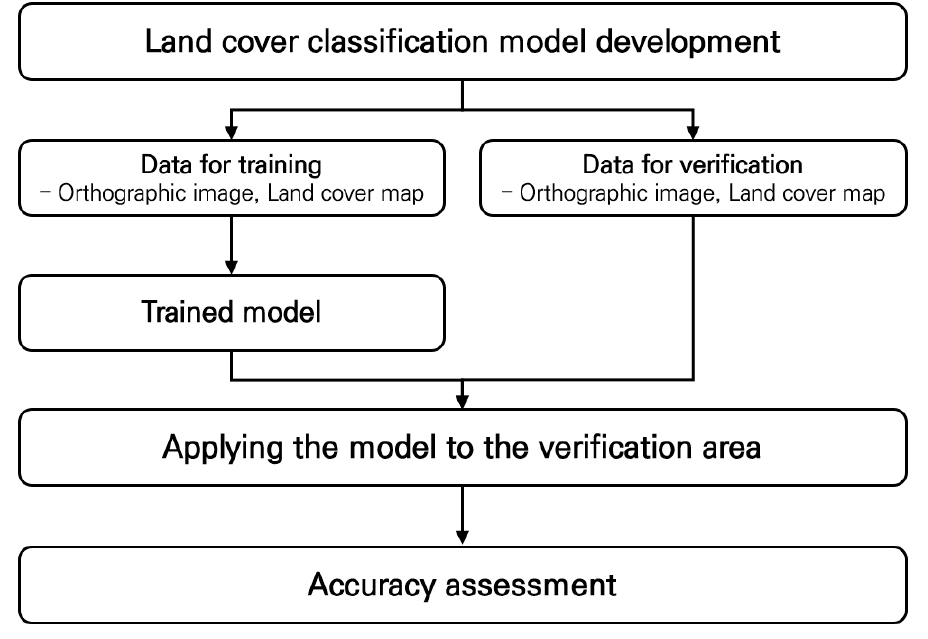
Figure 4. Schematics of the study procedure.